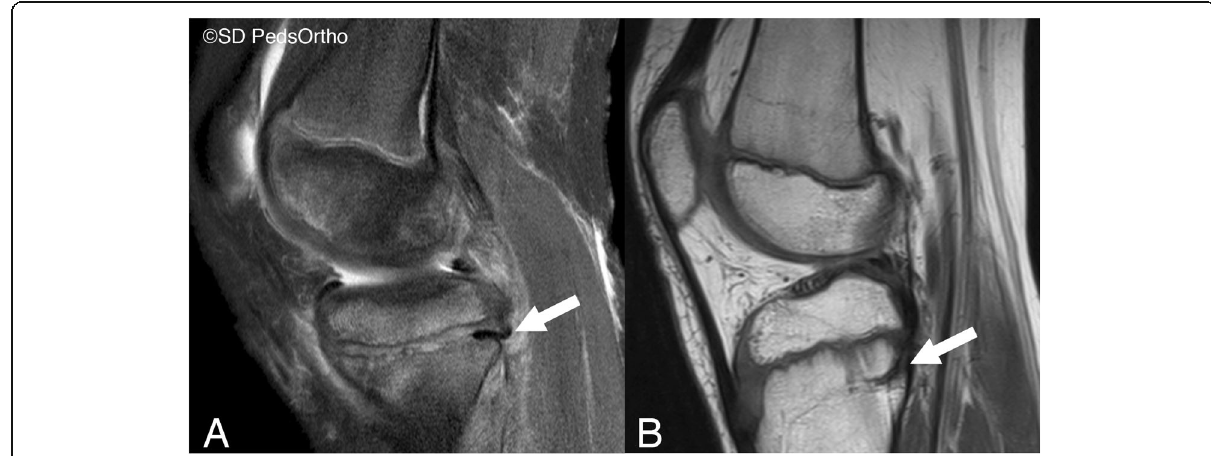
Fig. 1 A 10 year old boy from our clinic practice. a Index MRI of the proximal tibial physis with evidence of periosteal tissue entrapment posteriorly (arrow); treated non-operatively. b 16-month follow-up MRI with continued growth, but evidence of periosteal remnant